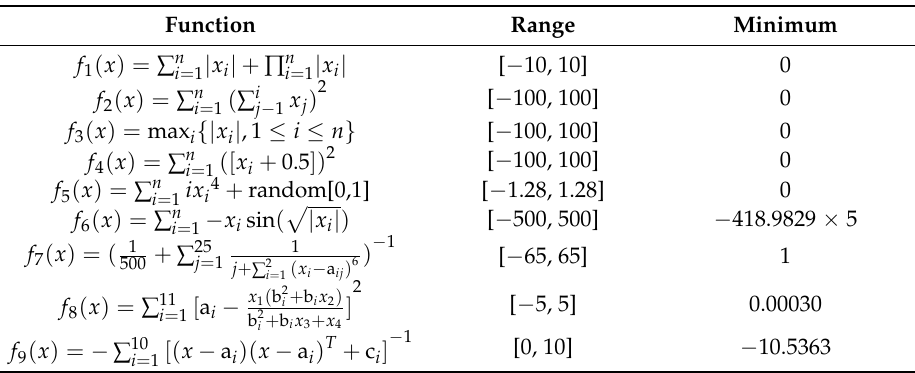
Table 2. Benchmark